Question: What type of chart is this?
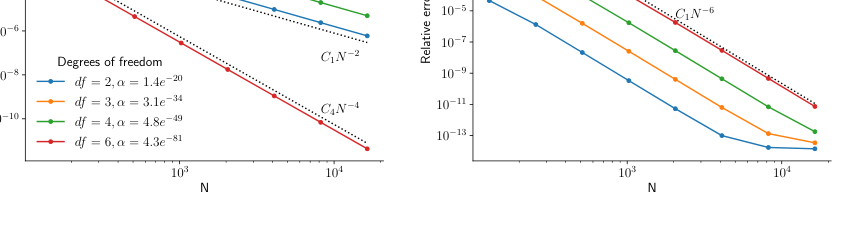
Answer: line